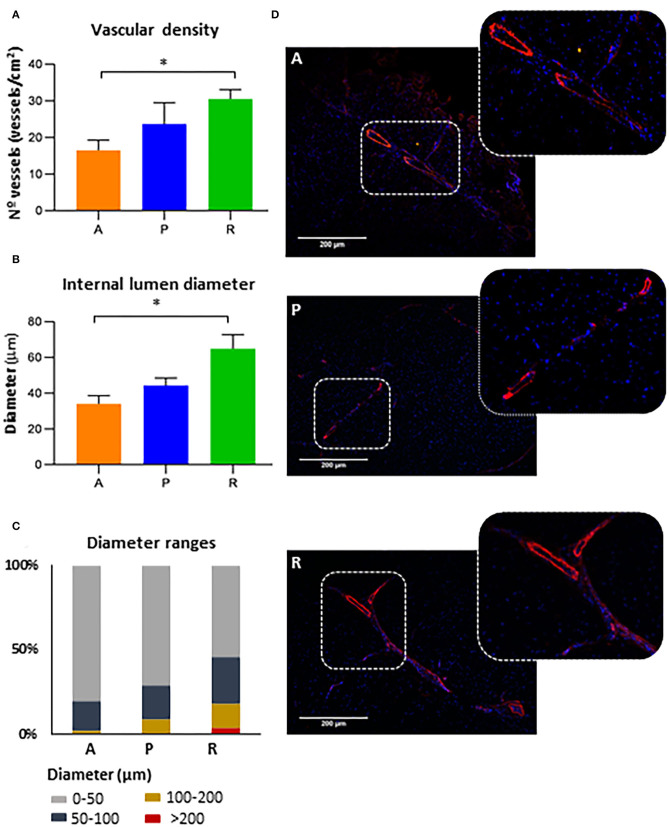
Vasculogenesis and arteriogenesis. (A) The number of blood vessels (vessels/cm2) and (B) diameter sizes (μm) were measured for mice administered with adjuvants (A, n:14), placebos (P, n:15) or REX-001 cells (R, n:20). (C) Vessel classification based on abundance percentage of different ranges of internal lumen diameter (μm). (D) Representative IHC images to measure vascular density and diameter size are shown, using anti-mouse smooth muscle α-actin (red) and DAPI (blue). Data were presented as mean ± SEM. Significant differences were seen between the REX-001 (R) and adjuvant (A) treated mice (*p-value < 0.05), calculated with a one-way ANOVA, and Tukey post-hoc tests.